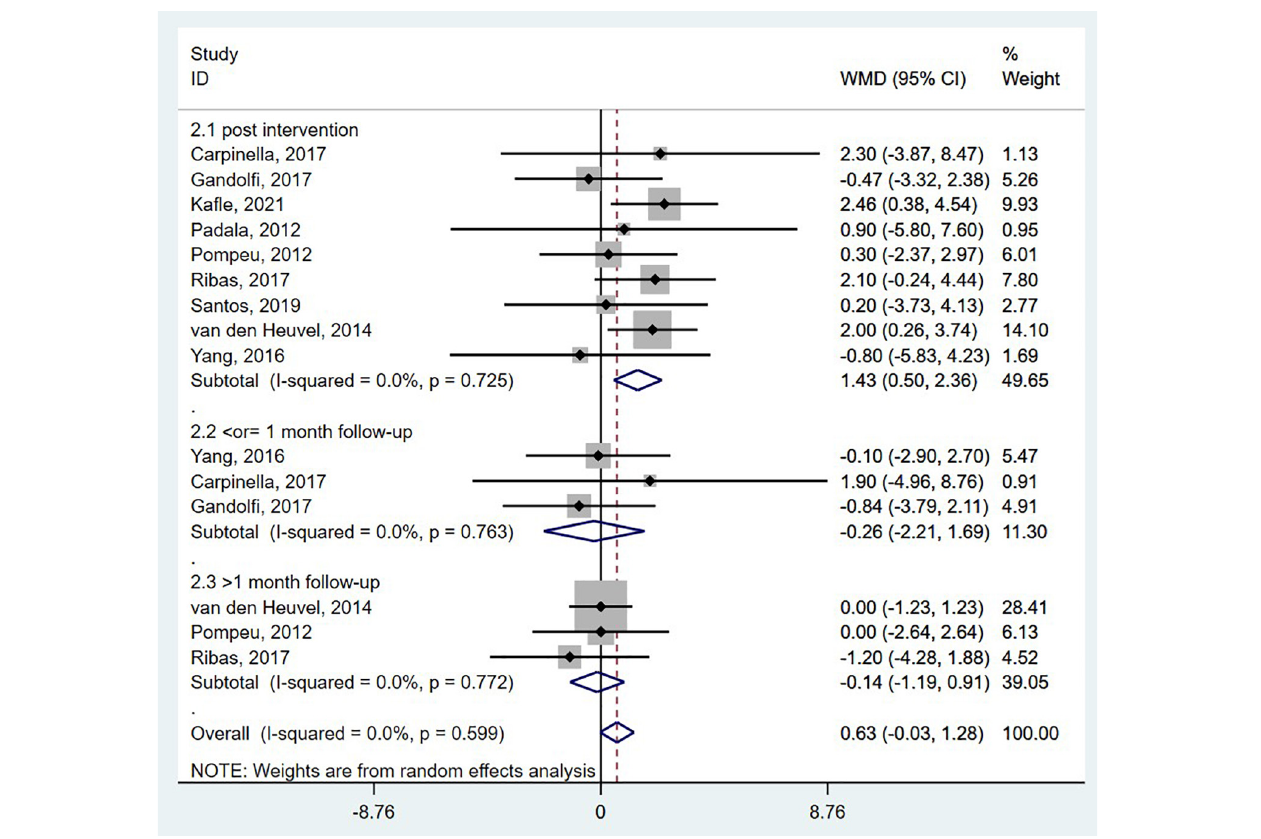
FIGURE 2 | Forest plot of pooled results for the Berg balance